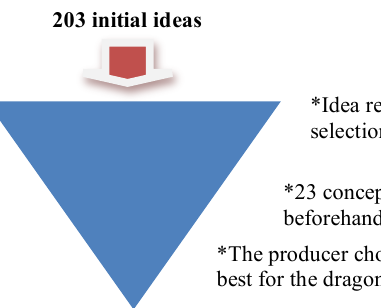
Fig. 8. Idea funnel of the innovation project. Fig. 9 illustrates the winning concept, the access control jewel. From the left: a 3D model, quick prototype, and operational test. The frame of the prototype was made with a 3D plastic printer. A RFID tag was placed between the frame and jewel stone.